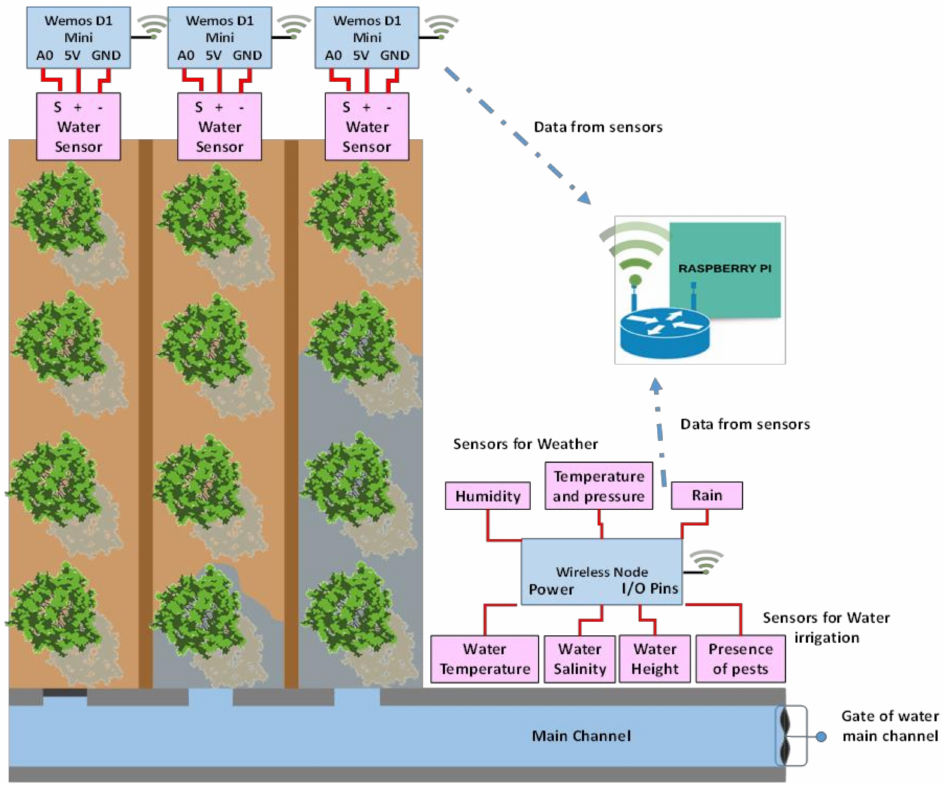
Figure 1. Proposed system for controlling the flood irrigation in